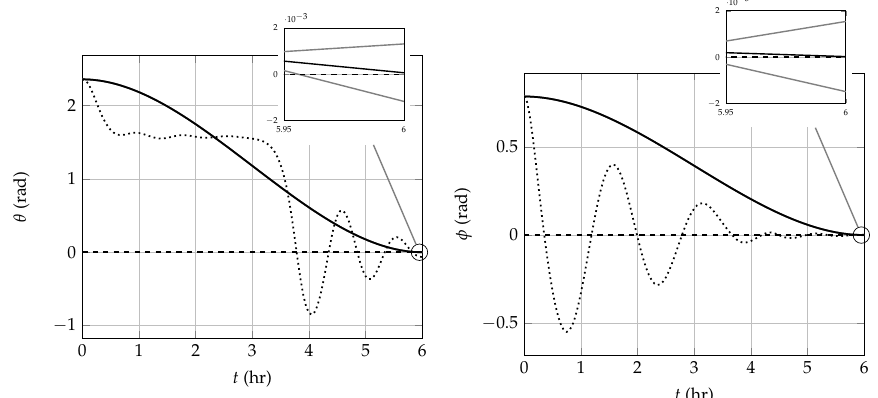
Figure 4. Angular displacement trajectories of the spacecraft. The black curves are the angular displacements of the actual nonlinear system, whereas the gray curves are the angular displacements of the auxiliary linear systems. The dashed line is the desired final position and the dotted line a solution using a non-convex solver.